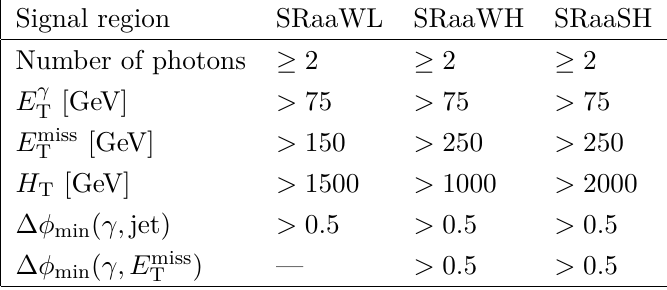
Table 5. Signal regions of ref. [70] that are referenced in figures 9 and